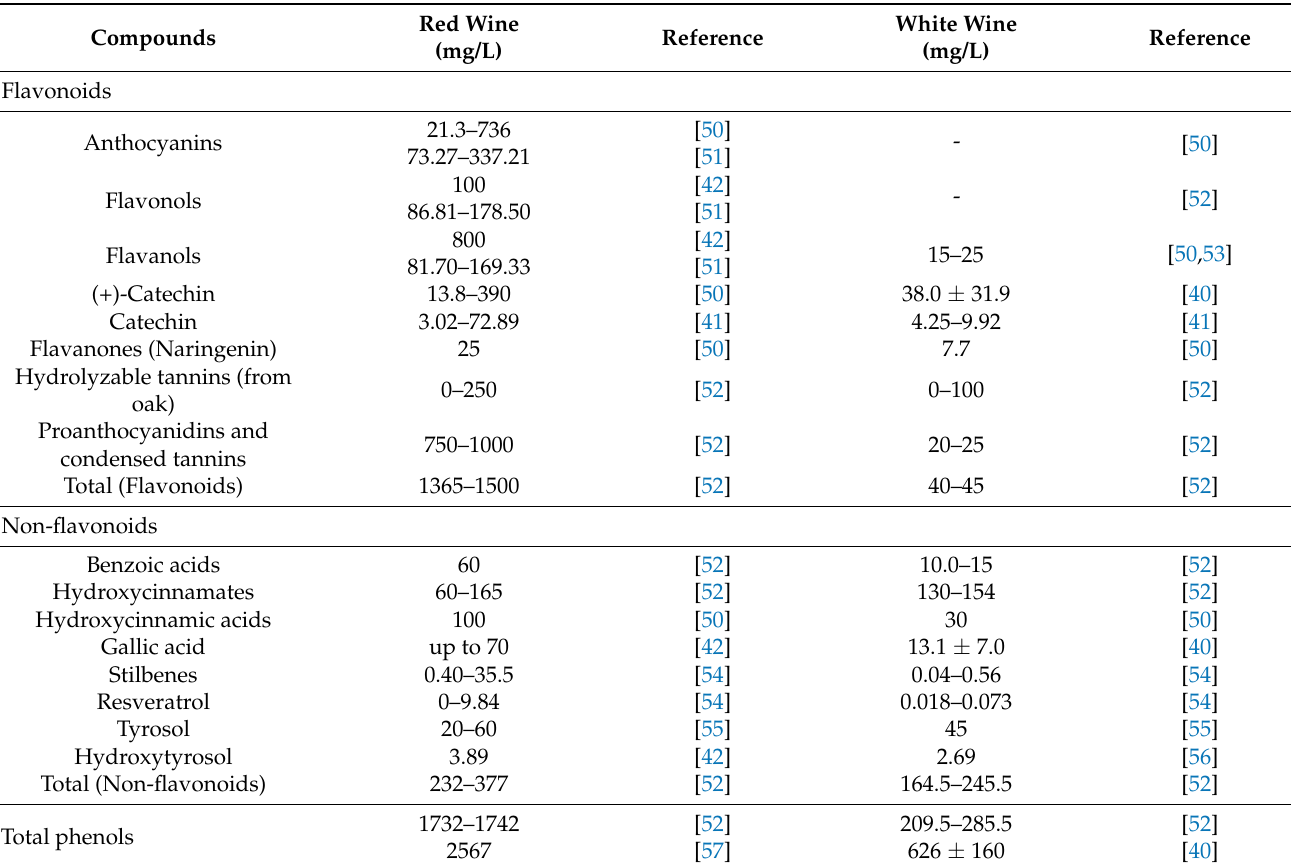
Table 1. Phenolic compounds of red and white wines, expressed as gallic acid equivalents (mg